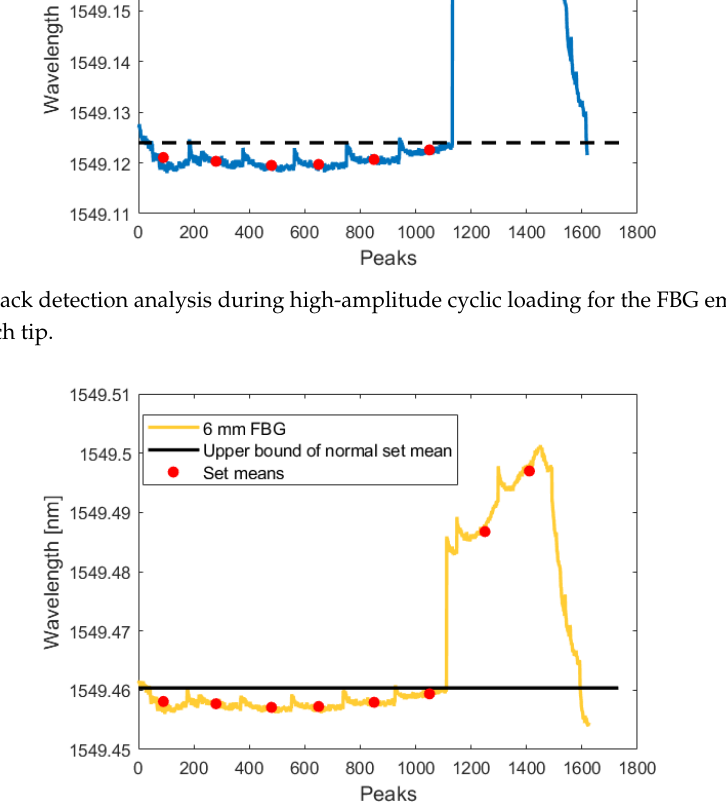
Figure 19. Crack detection analysis during high-amplitude cyclic loading for the FBG embedded 6 mm from the notch tip.